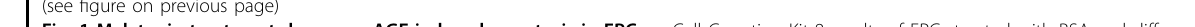
(Fig. 2e). The adaptor protein p62 (SQSTM1) connects LC3 protein to a ubiquitination substrate and can be incorporated into the complete phagosome by fi nal autophagic lysosomal degradation, marking the comple- tion of autophagic fl ux, and the accumulation of p62 indicates disrupted autophagic degradation 24 . In our study, Western blotting indicated that AGEs simulta- neously increased p62 expression in EPCs. The fl uores-